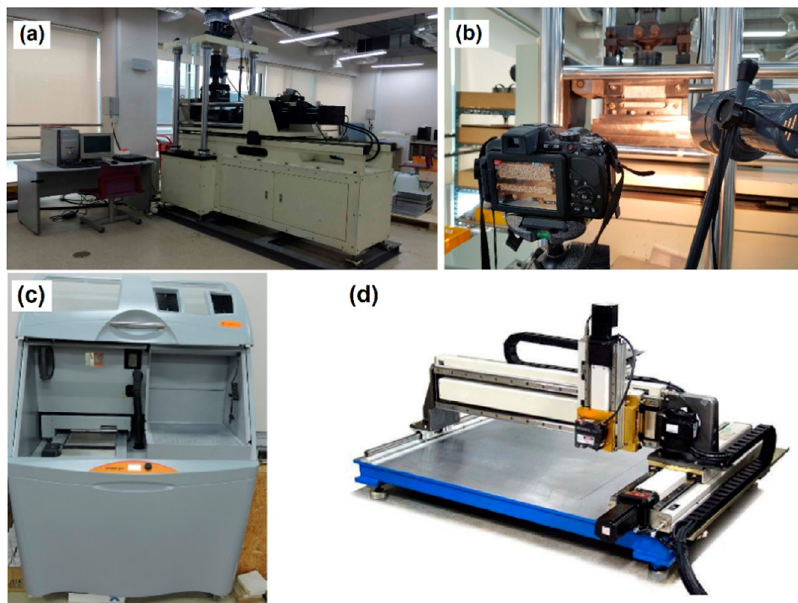
Figure 1. The equipment applied in this study; ( a ) Servo-controlled direct shear test machine, ( b ) Camera (Nikon, COOLPIX P600), ( c ) Zprinter ® 450, ( d ) 3D laser profiler.